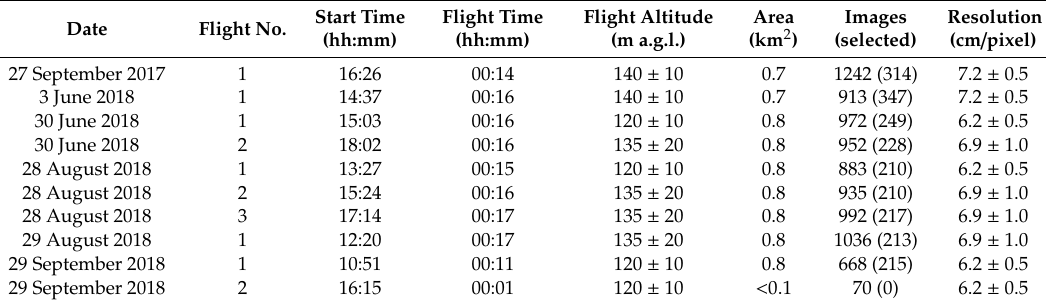
Table 1. Characteristics of the ten UAV surveys performed at the Kanderfirn in 2017 and 2018. Date Flight No.